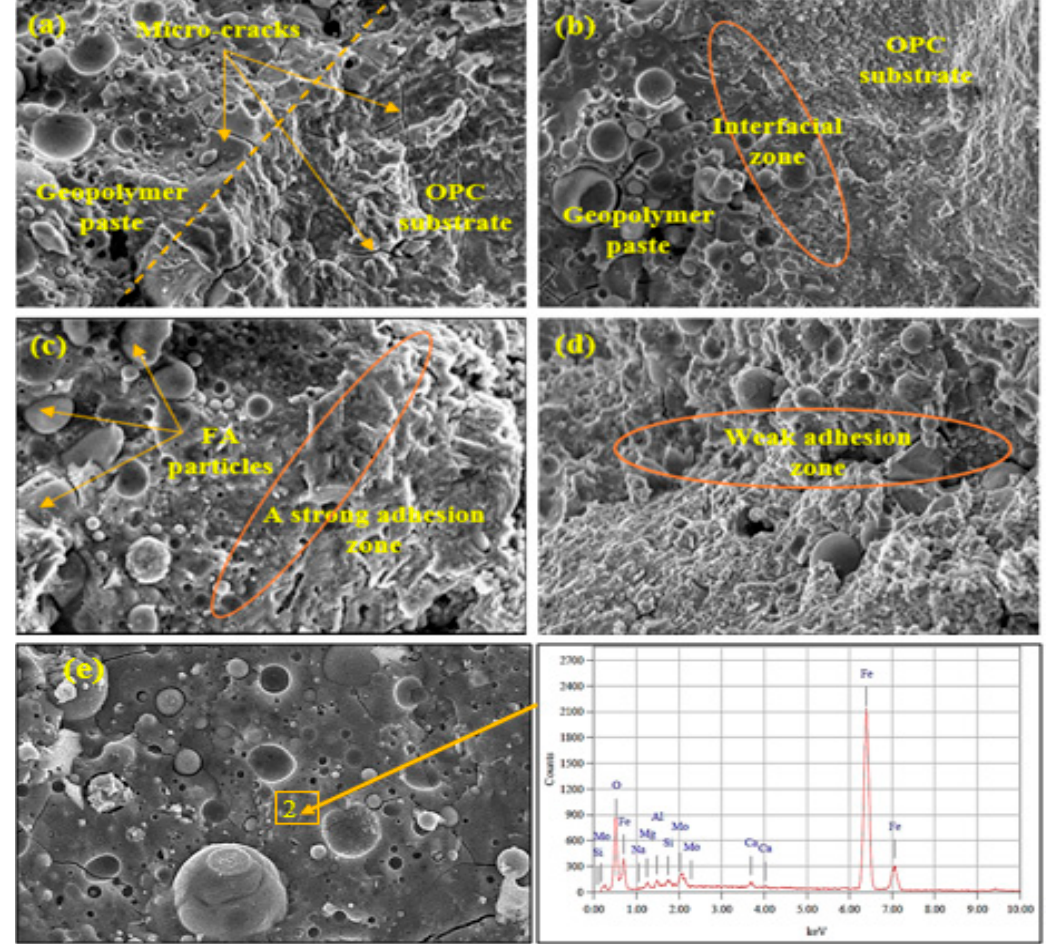
Figure 9. SEM images at the bonding zone (BZ) with; ( a ) 8 M, ( b ) 10 M, ( c ) 12 M, ( d ) 14 M, ( e ) energy- dispersive X-ray (EDX) analysis shows the contribution of iron oxide in the geopolymerization.